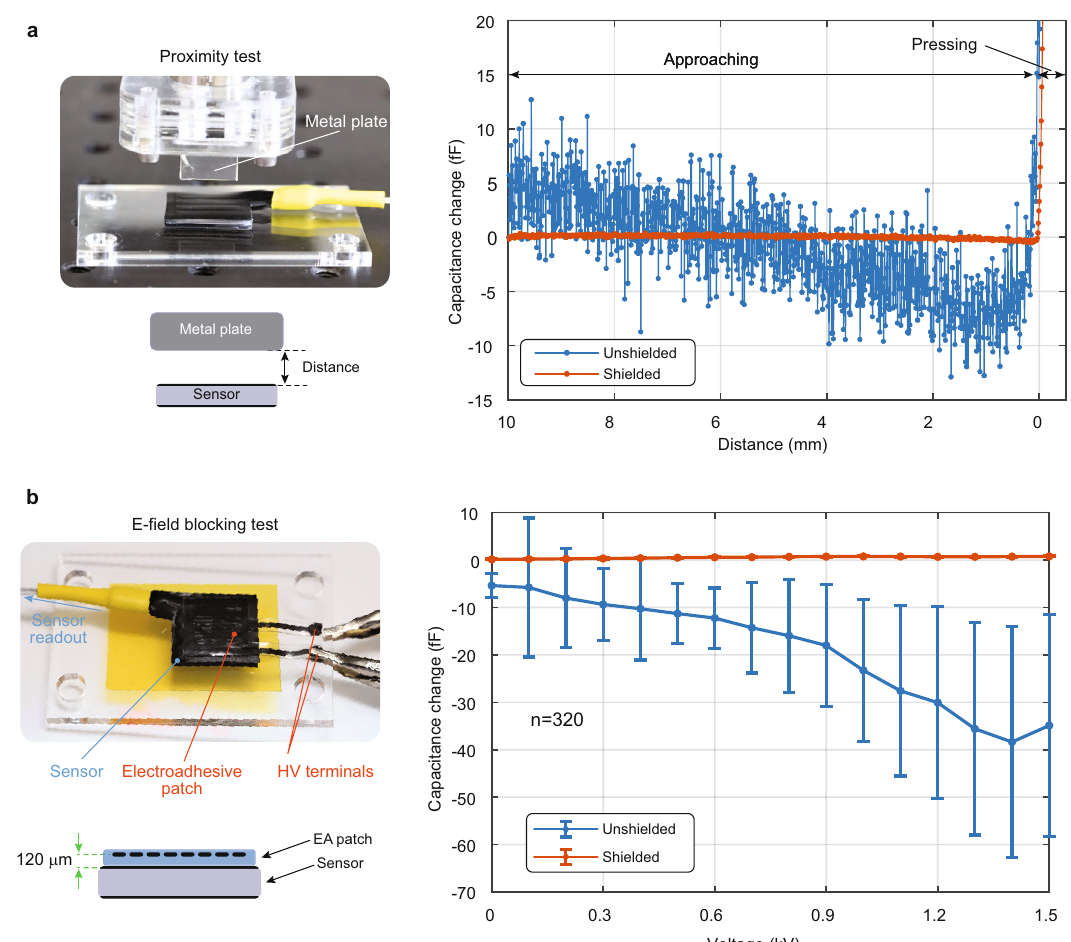
Fig. 3 | Noise comparison between the shielded and unshielded sensor. a The capacitance change of a shielded and an unshielded sensors when approaching a metalplate. b Thecapacitancechangesduetothefringingelectric fi eldofanearby electroadhesive patch thatisoperated atACvoltage up to1.5kV.In both scenarios